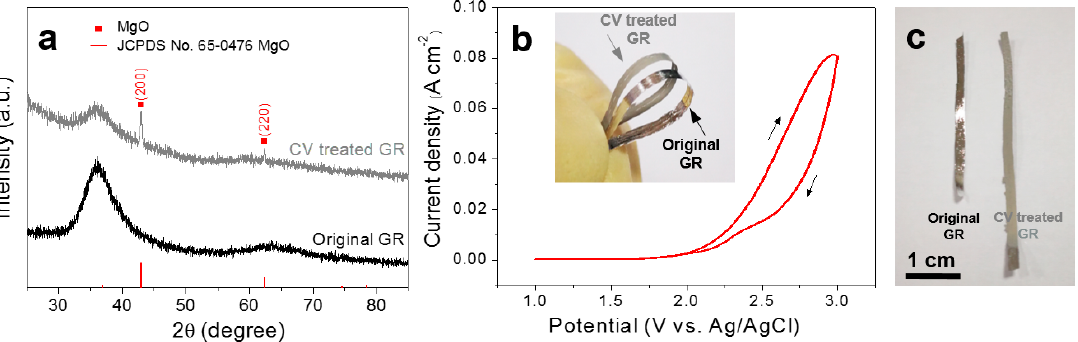
Figure 2. ( a ) X-ray diffraction (XRD) pattern; ( b ) cyclic voltammogram (CV) treatment towards a GR; the inserts: digital photo of GRs with good bendability; ( c ) digital photo of GRs before and after CV treatment .